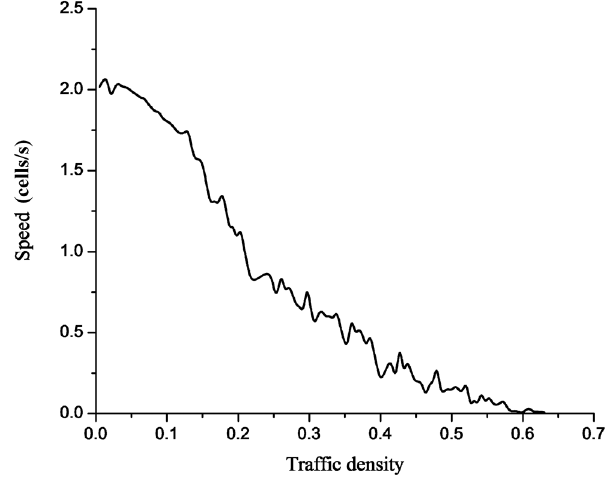
Figure 5. The relationship between traf fi c density and average speed at the roundabout obtained by